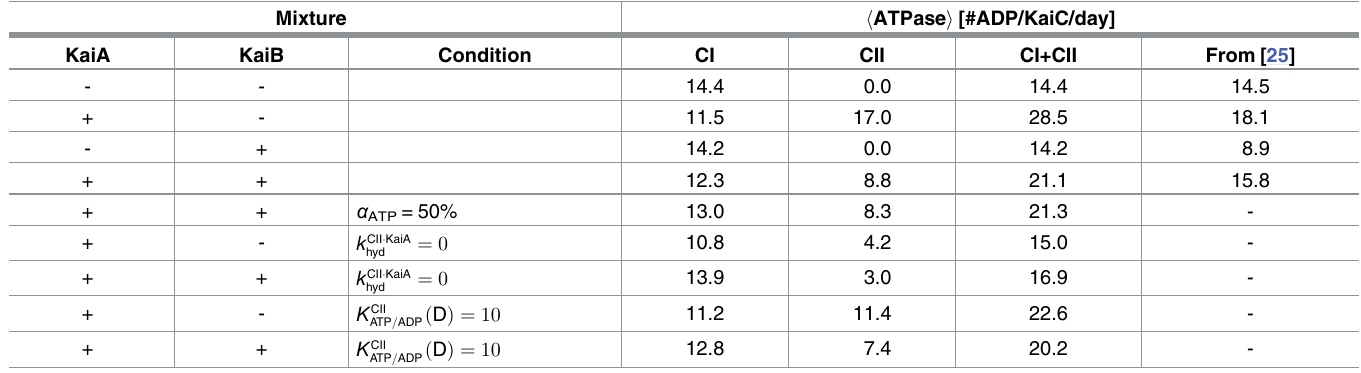
Table 4. Measured ATPase activity in ADP molecules produced per KaiC monomer per day (24 hours), under different conditions. First rows show ¼ 0 , the ATP hydrolysisin the CII domain results for parameters given in Tables 2 and 3. The last four rows show results for alternativemodels. When k CII (cid:1) KaiA hyd ¼ 10 , the CII domainhas a higherrelativeaffinity for ADP when the monomeris in the D state. The exper- is blockedwhen KaiA is boundto CII. When, K CII ATP = ADP imentalvalues for the combinedATPase activity of the CI and CII domain,given in the last column, are taken from [25], and are shown for